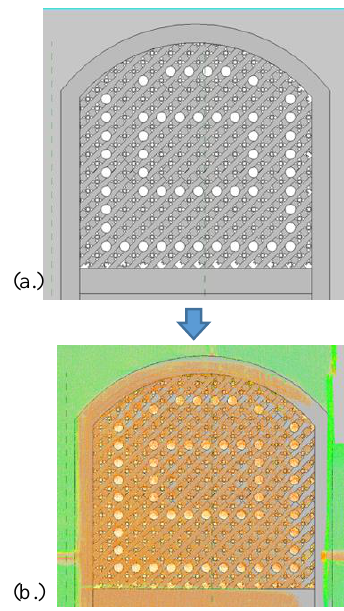
Figure 14. Modelling the Manjur pattern in 3-D. (a.) The final result of the 3-D modelling. (b.) Comparing between the point cloud and the 3-D model of the Manjur.